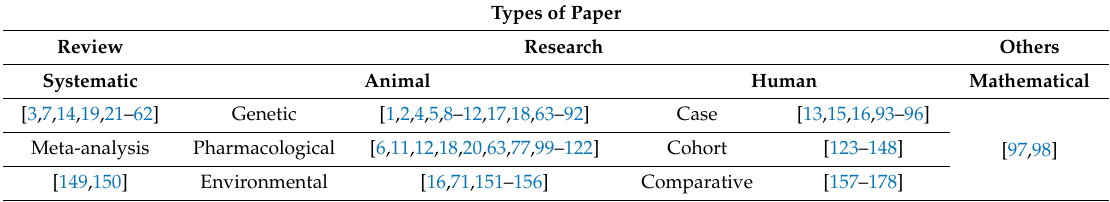
Figure 2. The search strategy used to identify references in this review. Table 1. Classification of the types and methodological components of papers contributing to the